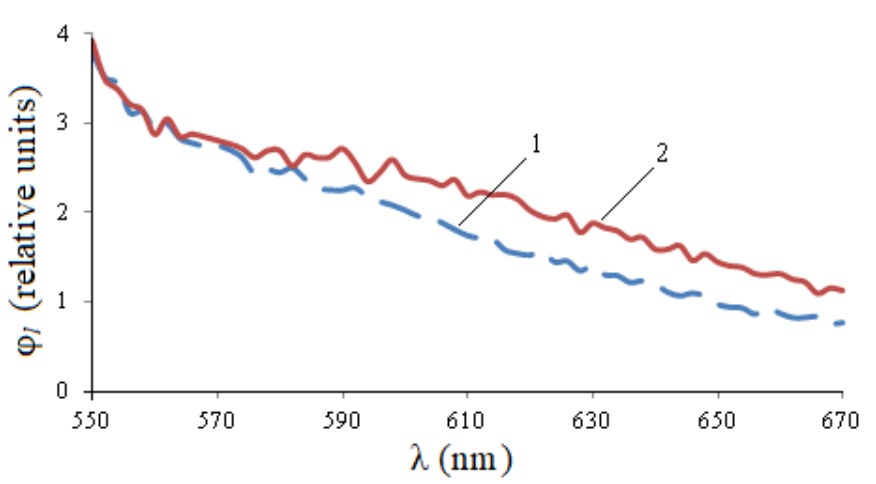
Figure 6. Spectral characteristics of luminescence of wheat seeds at λ e , 4 = 485 nm: 1 — not infected, 2 — 98% infected.